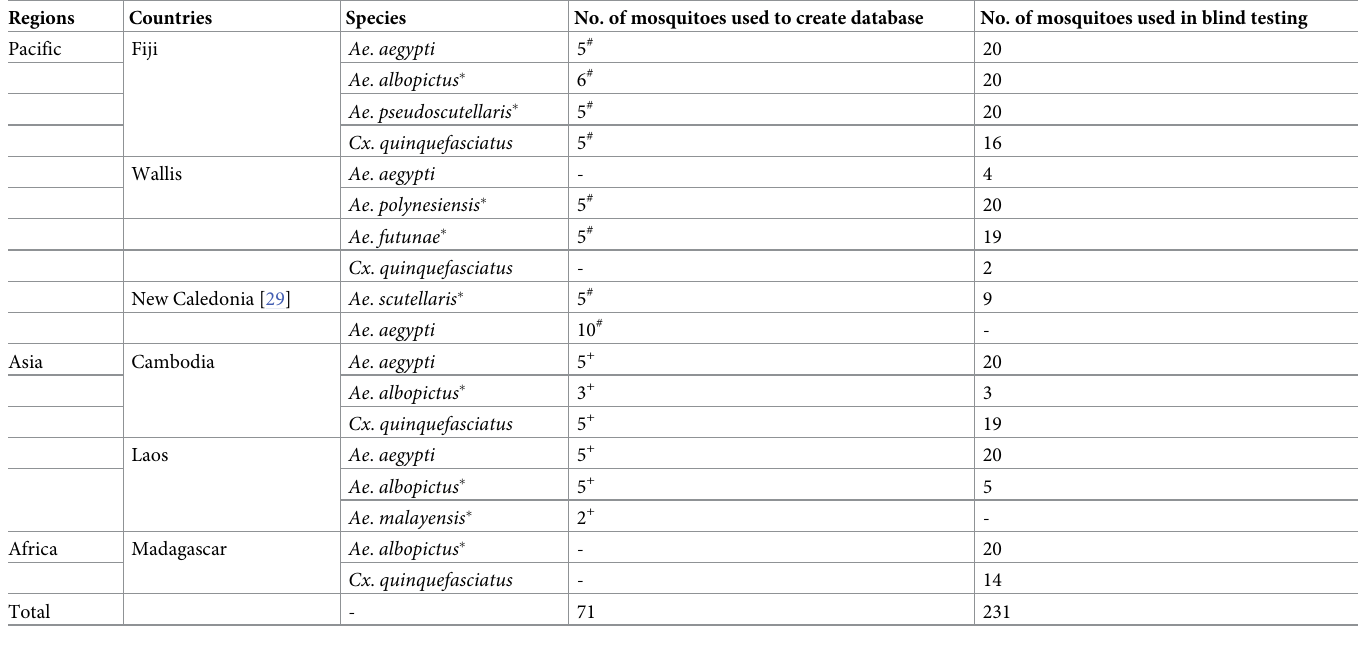
Table 1. Mosquitoes collected from each region.